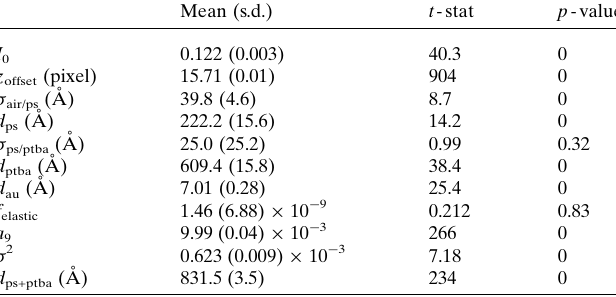
Table 3 XWFH results.